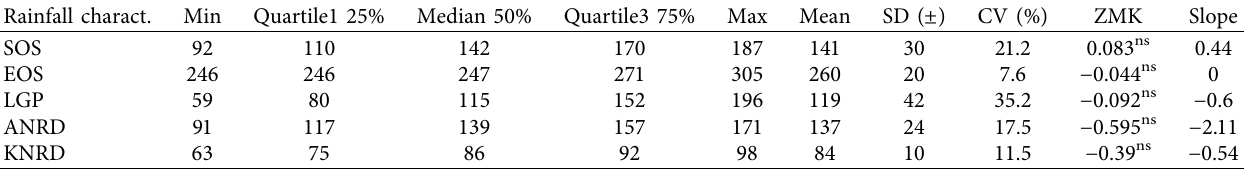
Table 2: Rainfall characteristics for Welmera district in the period of 1988–2017 years. Rainfall